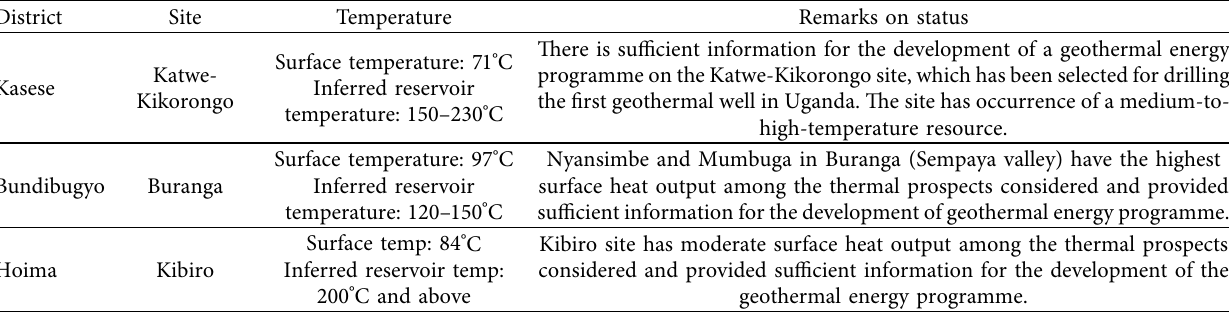
Table 10: Prospective geothermal sites in Uganda